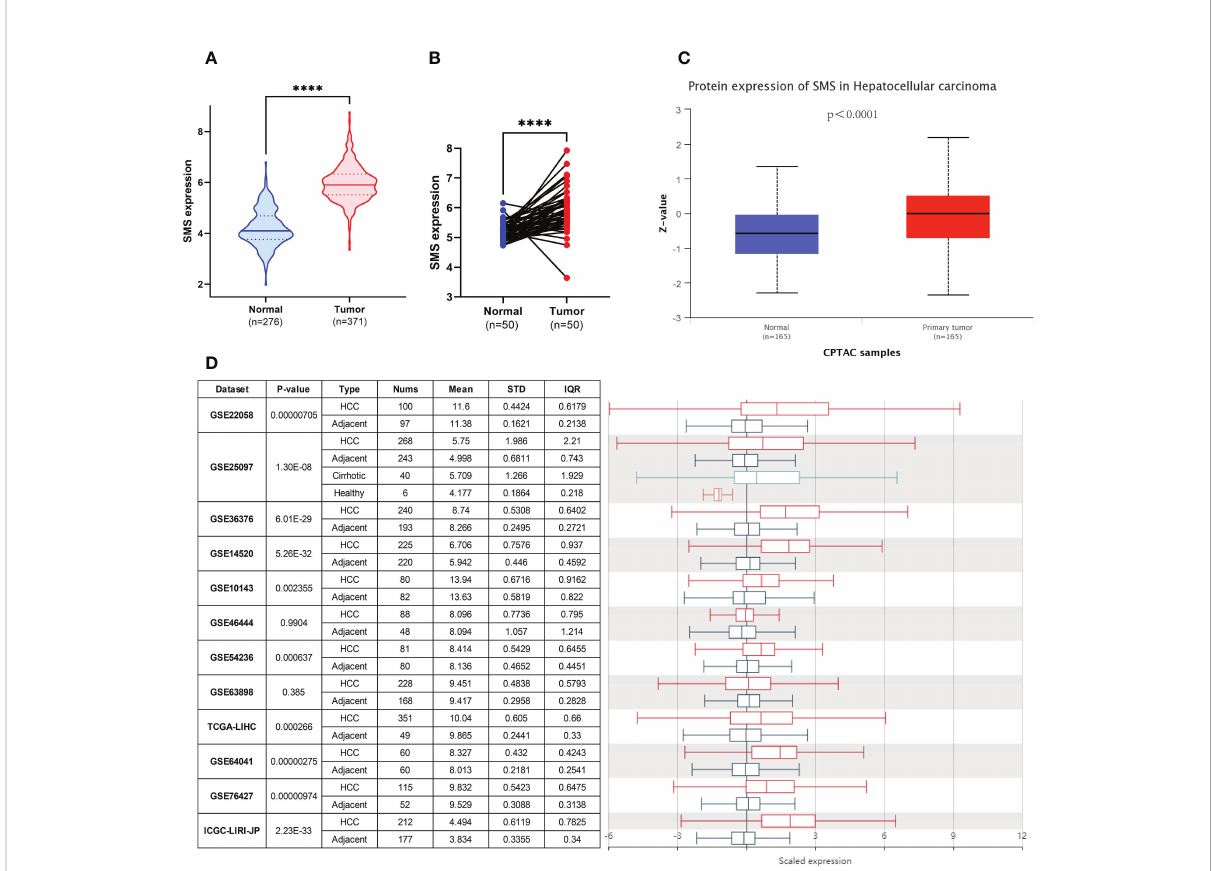
FIGURE 2 Upregulation of SMS in HCC. (A) SMS mRNA expression in 371 HCC samples (371 in TCGA-LIHC) and 276 normal samples (50 in TCGA-LIHC dataset and 226 in GTEx dataset). (B) SMS mRNA expression in 50 HCC and paired normal samples. (C) SMS protein expression based on CPTAC. (D) Comparison of the transcriptional level of SMS between HCC tissues and paired normal tissues in HCCDB. ****p < 0.0001 vs. indicated